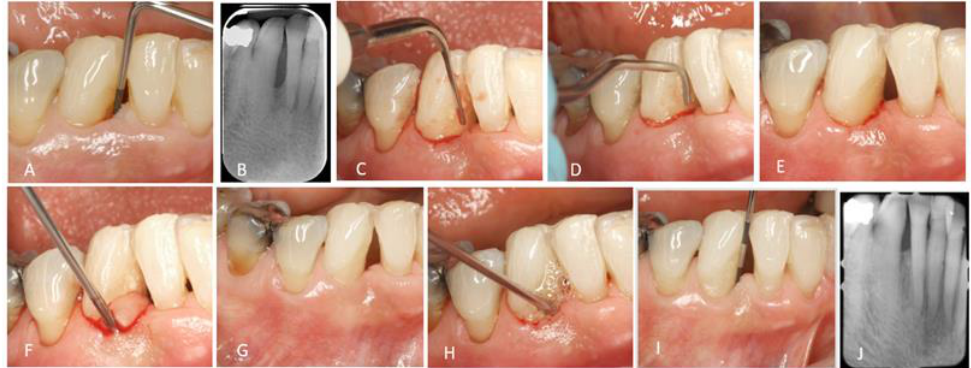
Figure 1. MINST + EMD application: ( A , B ) Initial clinical and radiographic images; ( C ) Use of ultrasonic delicate tip; ( D ) Use of mini curette; ( E ) After MINST (notice the minimal tissue trauma); ( F ) EDTA application; ( G ) Dried tooth surface; ( H ) EMD application; ( I , J ) Clinical and radiographic images at 12 months.